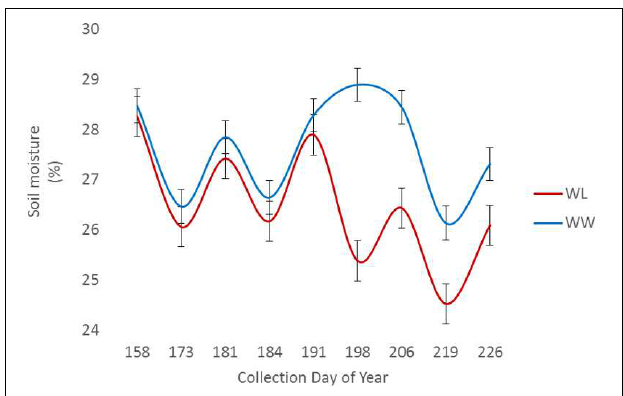
FIGURE 4 | Average volumetric soil moisture content to a depth of 140 cm among sample locations for well-watered (WW) and water-limited (WL)